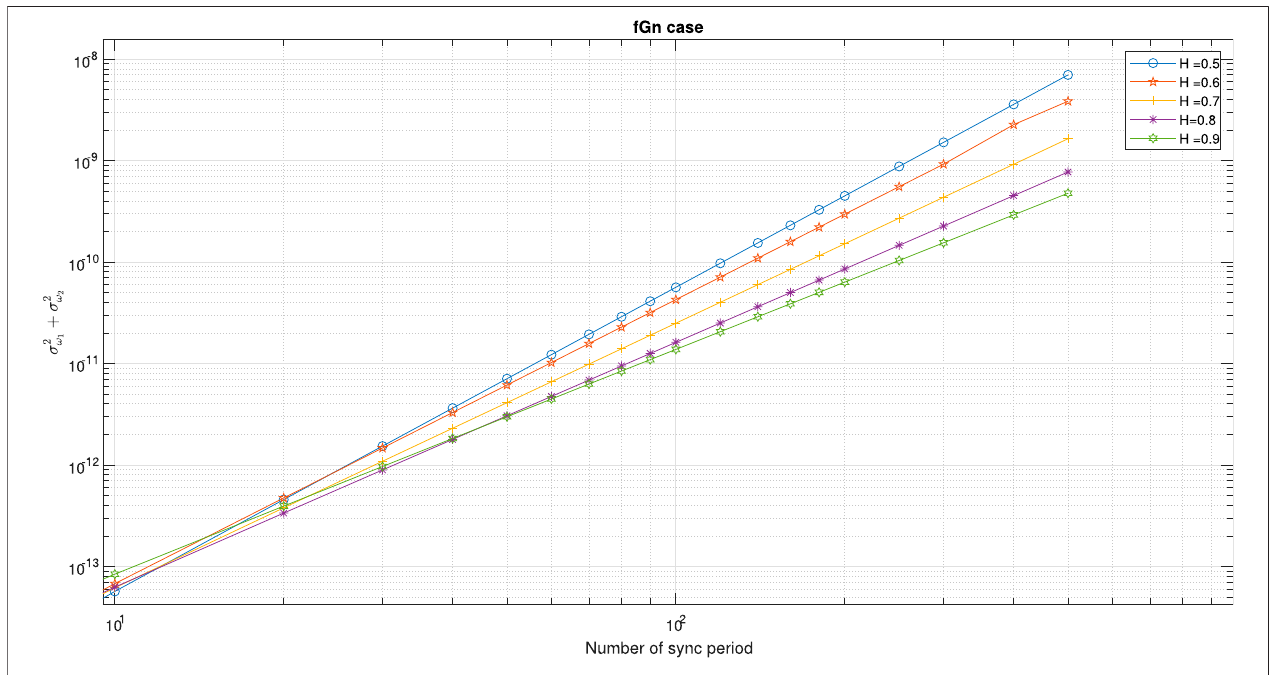
FIGURE 2 | Designing graph for the fGn case. The graph is based on Eq. 86 , T syn (cid:1) 15 . 6 ms ( 64 packet